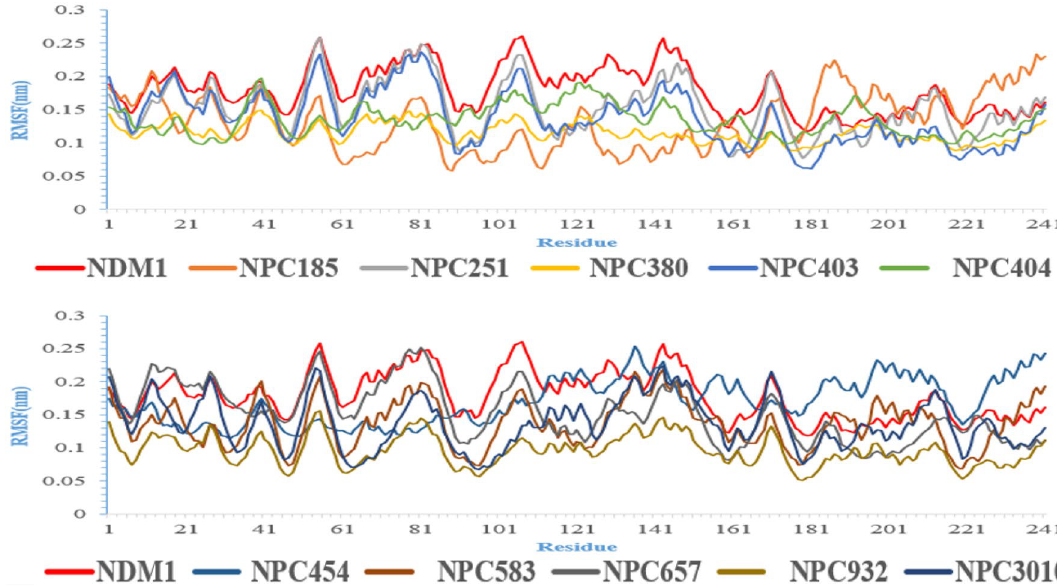
Figure 7. RMSF analyses of all complexes during the last 10 ns of MD simulation.